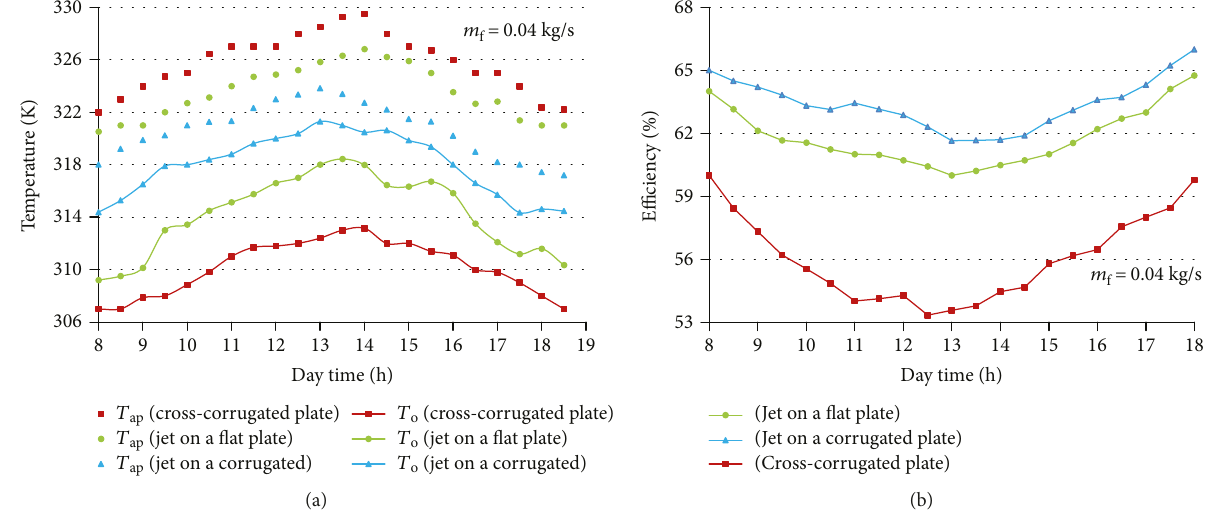
Figure 18: Hourly performance parameters under the purview of three designs of solar air heater. (a) Absorber plate temperature and air outlet temperature. (b) Collector e ffi